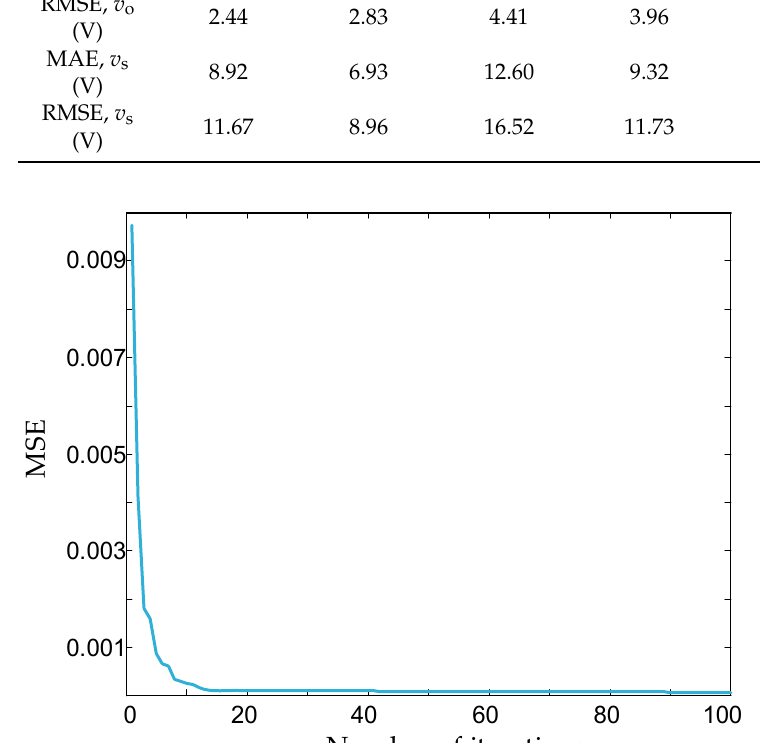
Figure 7. MSE of the initial proposed PSO algorithm versus the number of